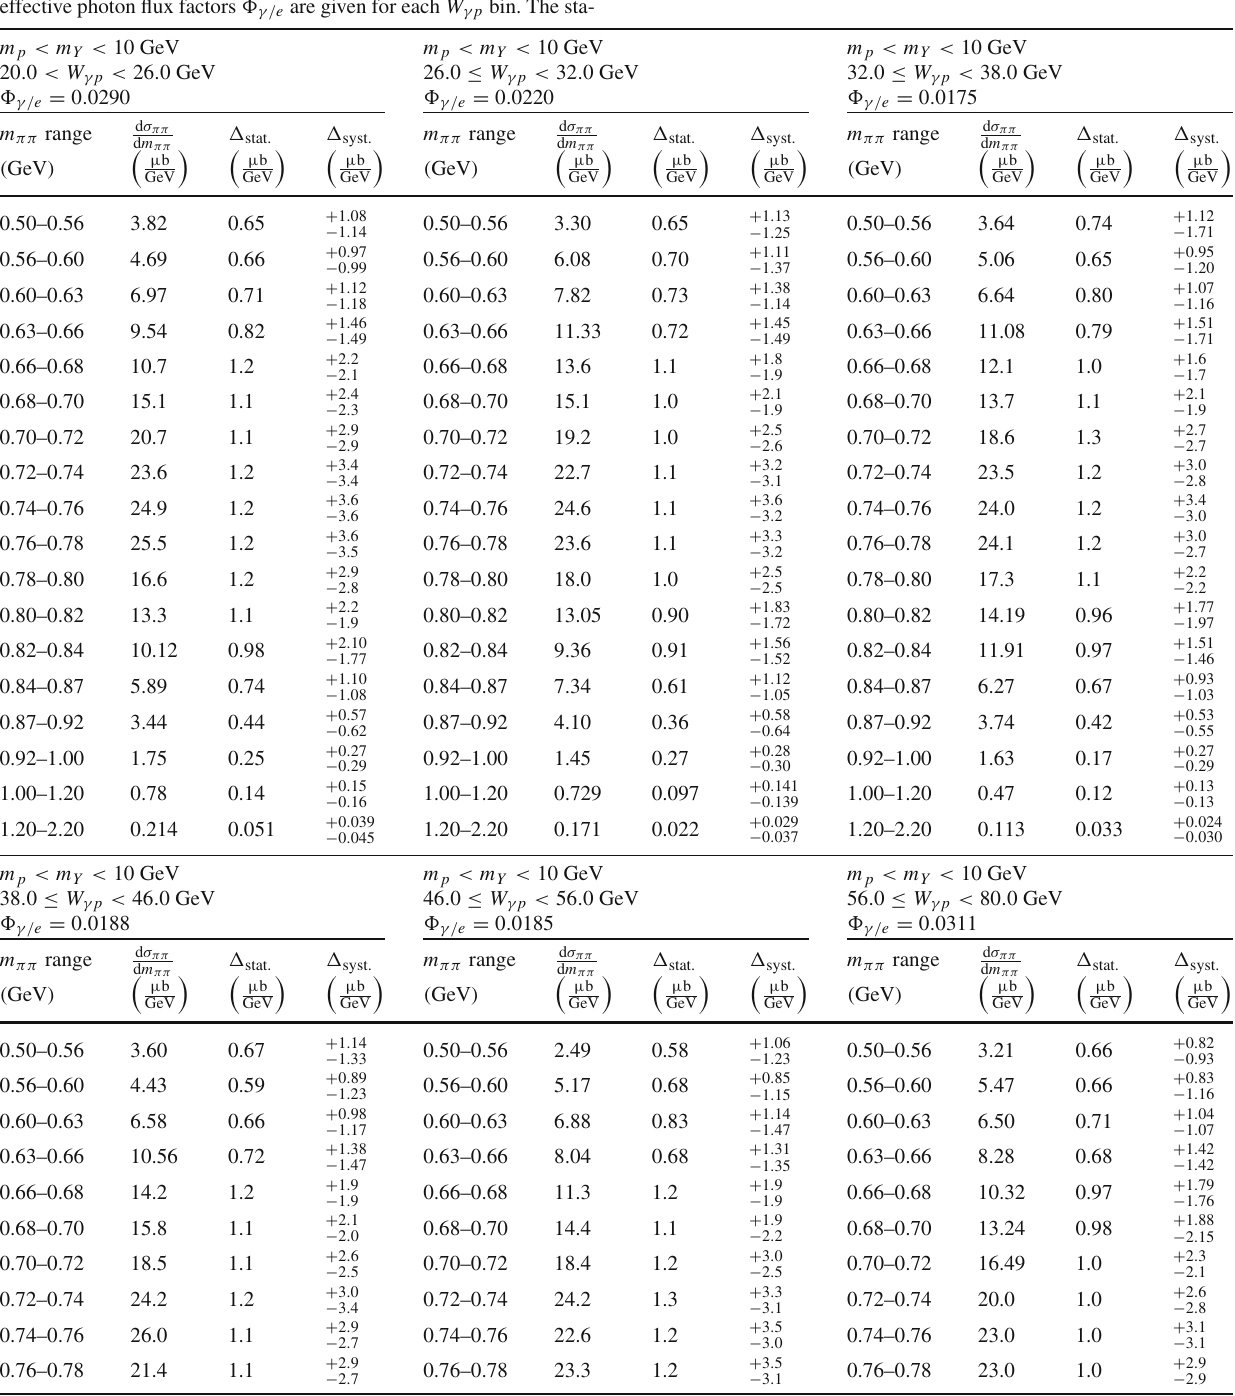
Table 19 Unfolded proton-dissociative ( m p < m Y < 10 GeV)